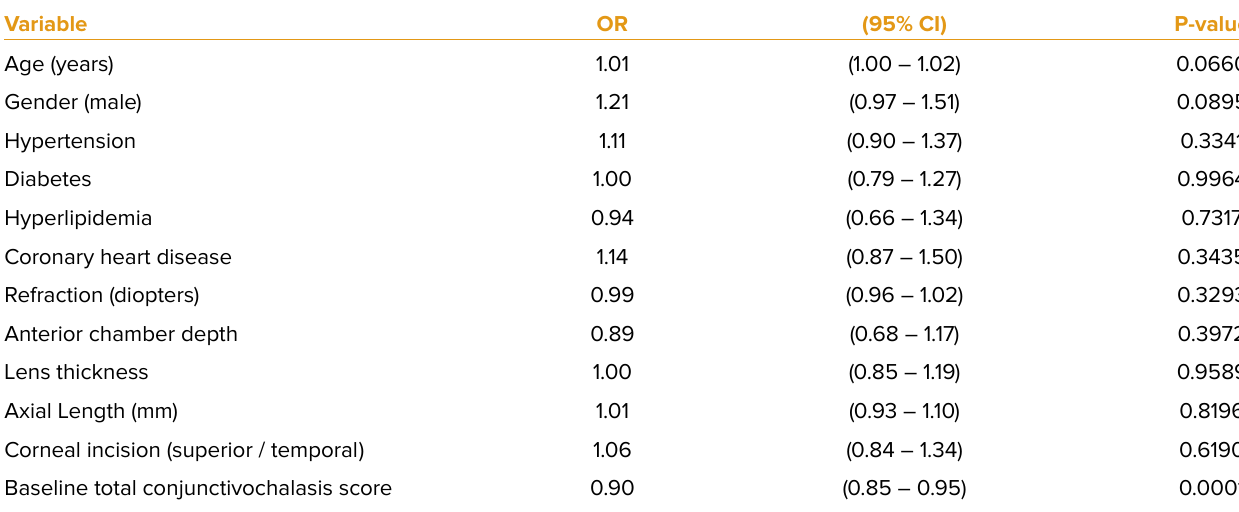
Table 1. Multivariate analysis of factors influencing progression of conjunctivochalasis (n = 83).